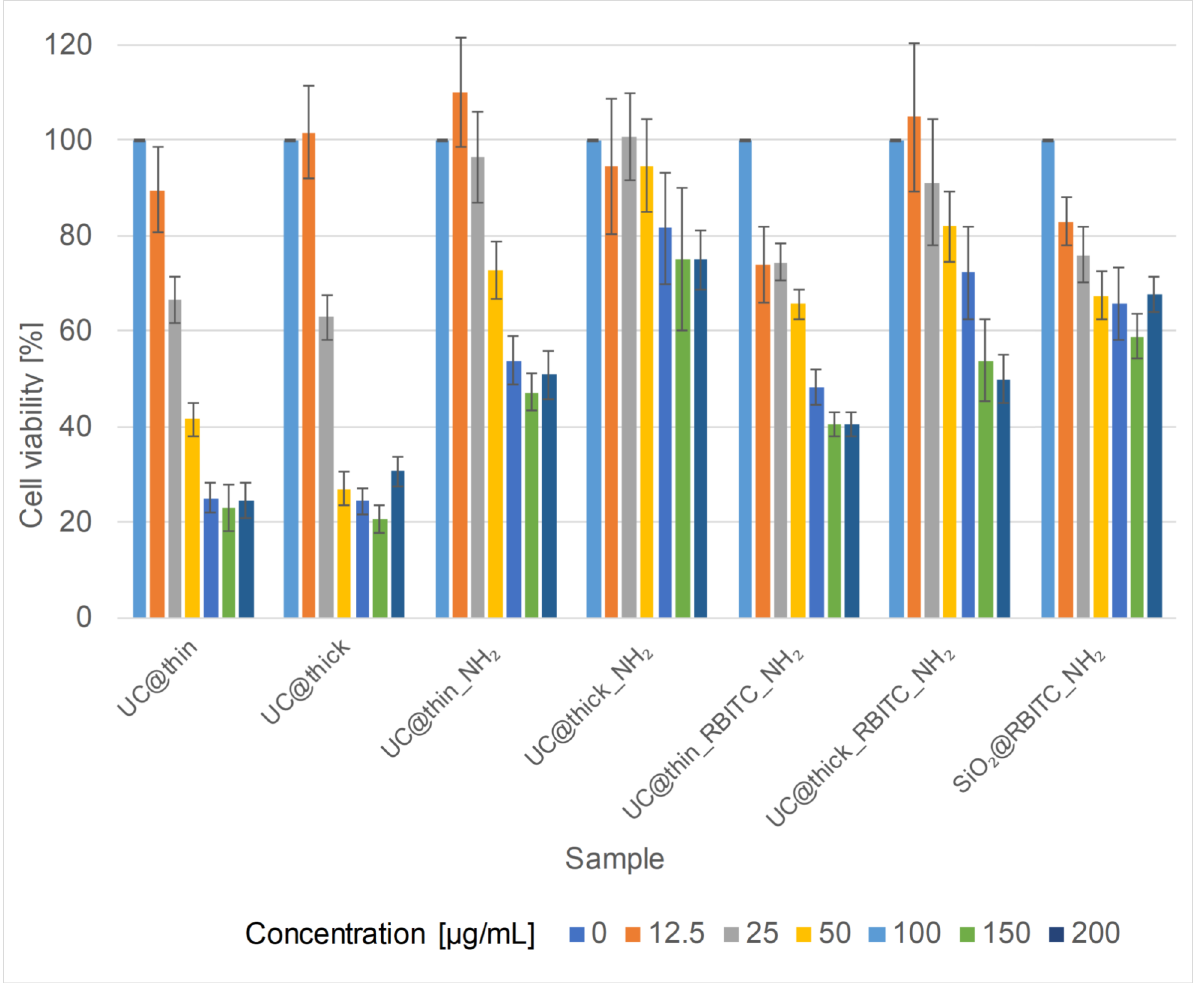
Figure 2: MTT assay results of silica-coated UCNPs and SiO 2 nanoparticles on RAW 264.7 cells.